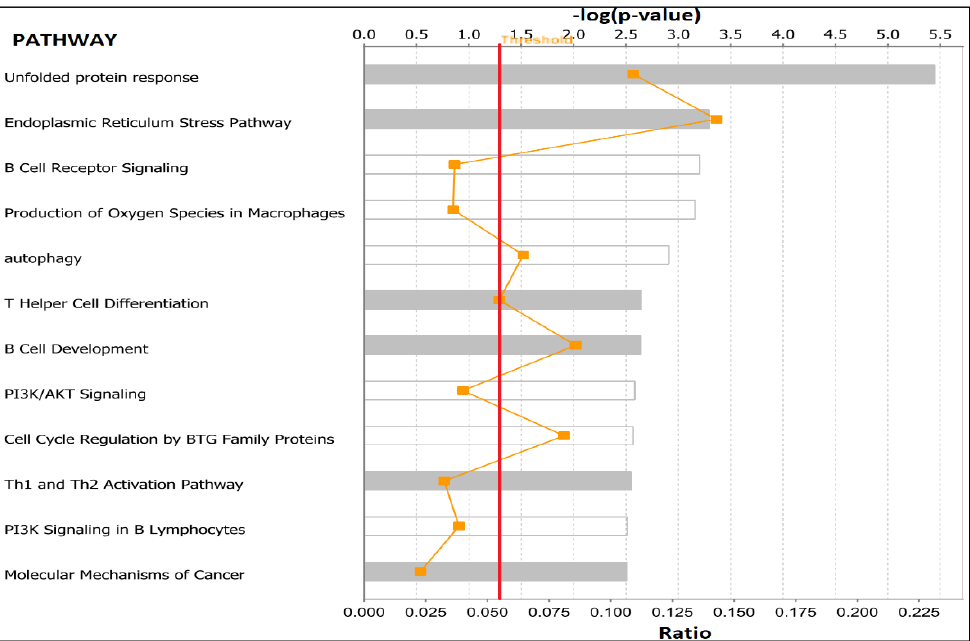
Figure 5. Molecular networks containing genes predicted to be significantly associated with obesity in premenopausal women. Network analysis was based on highly significantly differentially expressed genes ( p < 0.01) in red fonts. Gene symbols in red fonts were predicted to be highly (Figure 8). In addition, pathway analysis revealed the upstream regulators including TNF , TGFB1 , significantly associated with obesity. Genes in black symbols are predicted to be functionally related to genes in red fonts. The pink and black lines denote the relationships between merged networks.